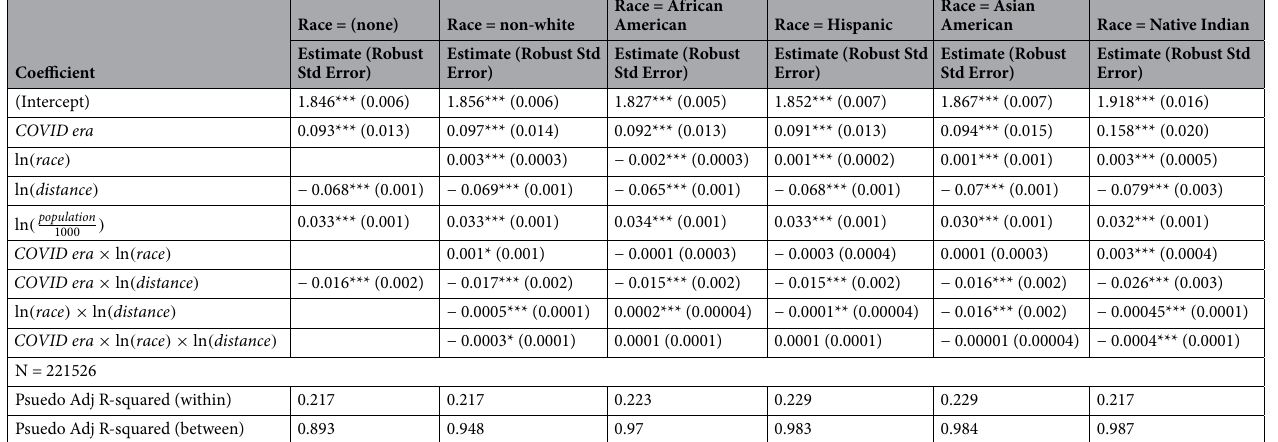
Table 1. Our summary of results reveal that visitation figures from non-white and Native American census block groups have been impacted due to COVID-19. While our results show that COVID-19 did not impact visitation figures from African-, Hispanic, and Asian-American communities, we could still gather insights into the existing travel behavior of these communities through the interaction terms of other significant variables (at P < 0.05 ). Signif. codes: 0 ‘***’ 0.001 ‘**’ 0.01 ‘*’